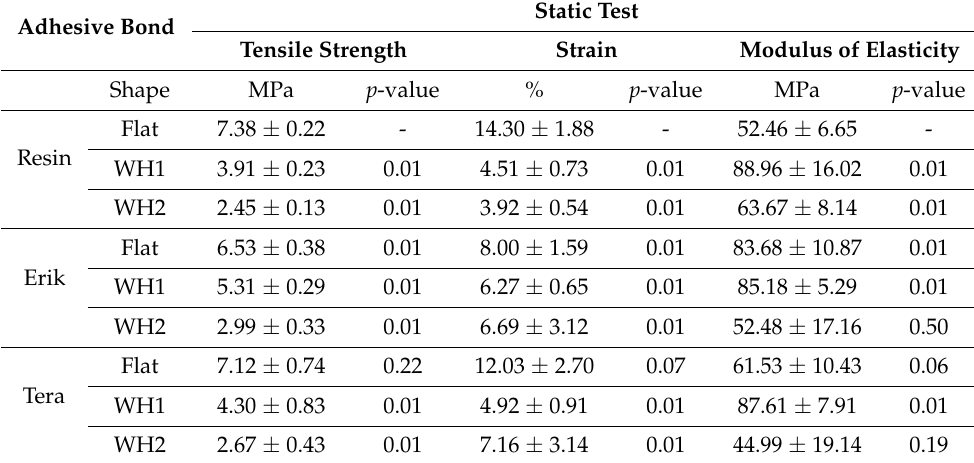
Table 5. Results of static tensile tests of adhesive bonds and statistical evaluation of data ( p -value). Adhesive